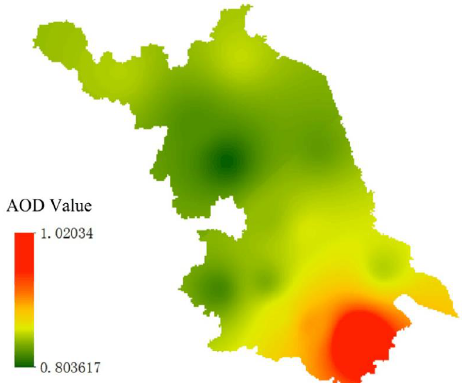
Figure 2. Spatial distribution of the mean of AOD in Jiangsu Province from 2007 to 2016